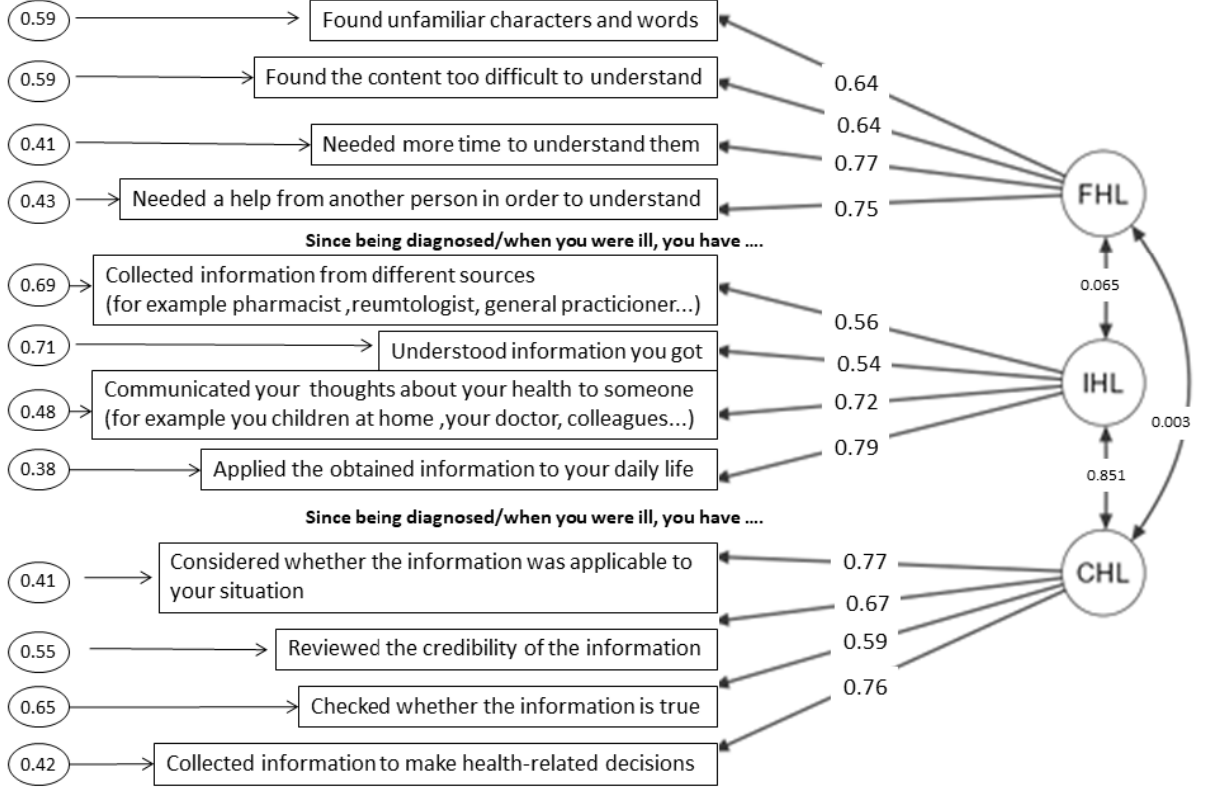
Figure 2. Summary of Structural Validity.